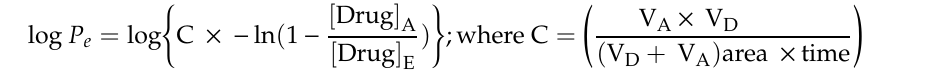
IR spectrum of compound 3 . Figure S5. MS-APCI spectrum of compound 3 . Figure S6. FT-IR spectrum of compound 8 . Figure S7. 13 C NMR spectrum of compound 8 . Figure S8. 11 B NMR {H BB} spectrum of compound 8 . Figure S9. IR spectrum of compound 8 . Figure S10. APCI-MS spectrum of compound 8 . Figure S11. HPLC analysis of compound 8 . Figure S12. 1 H NMR spectrum of compound 9 . Figure S13. 13 C NMR spectrum of compound 9 . Figure S14. 11 B NMR spectrum of compound 9 . Figure S15. IR spectrum of compound 9 . Figure S16. APCI-MS spectrum of compound 9 . Figure S17. HPLC analysis of compound 9 . Figure S18. 1 H NMR spectrum of compound 10. Figure S19. 13 C NMR spectrum of compound 10 . Figure S20. 11 B NMR spectrum of compound 10. Figure S21. IR spectrum of compound 10 . Figure S22. APCI-MS spectrum of compound 10 . Figure S23. HPLC analysis of compound 10 . Figure S24. 1 H NMR spectrum of compound 14 . Figure S25. 13 C NMR spectrum of compound 14 . Figure S26. 11 B NMR { 1 H BB} spectrum of compound 14 . Figure S27. IR spectrum of compound 14 . Figure S28. MS spectrum of compound 14 . Figure S29. HPLC analysis of compound 14 . Figure S30. 1 H NMR spectrum of compound 15 . Figure S31. 13 C NMR spectrum of compound 15 . Figure S32. 11 B NMR { 1 H BB} spectrum of compound 15 . Figure S33. IR spectrum of compound 15 . Figure S34. MS spectrum of compound 15 . Figure S35. HPLC analysis of compound 15 . Figure S36. 1 H NMR spectrum of compound 16 . Figure S37. 13 C NMR spectrum of compound 16 . Figure S38. 11 B NMR { 1 H BB} spectrum of compound 16 . Figure S39. IR spectrum of compound 16 . Figure S40. MS spectrum of compound 16 . Figure S41. HPLC analysis of compound 16 . Figure S42. 1 H NMR spectrum of compound 20. Figure S43. 13 C NMR spectrum of compound 20 . Figure S44. 11 B NMR { 1 H BB} spectrum of compound 20 . Figure S45. IR spectrum of compound 20 . Figure S46. MS